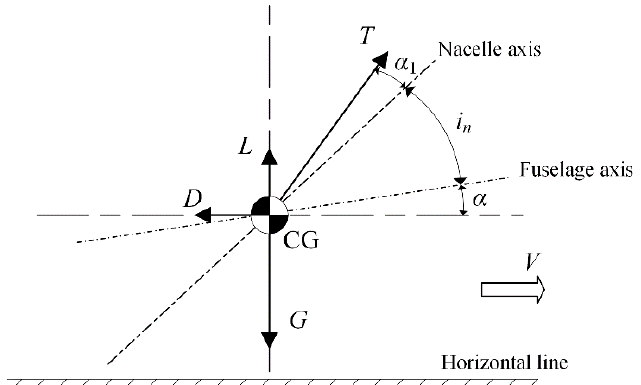
Figure 2. Longitudinal equilibrium of a V/STOL aircraft in conversion mode.